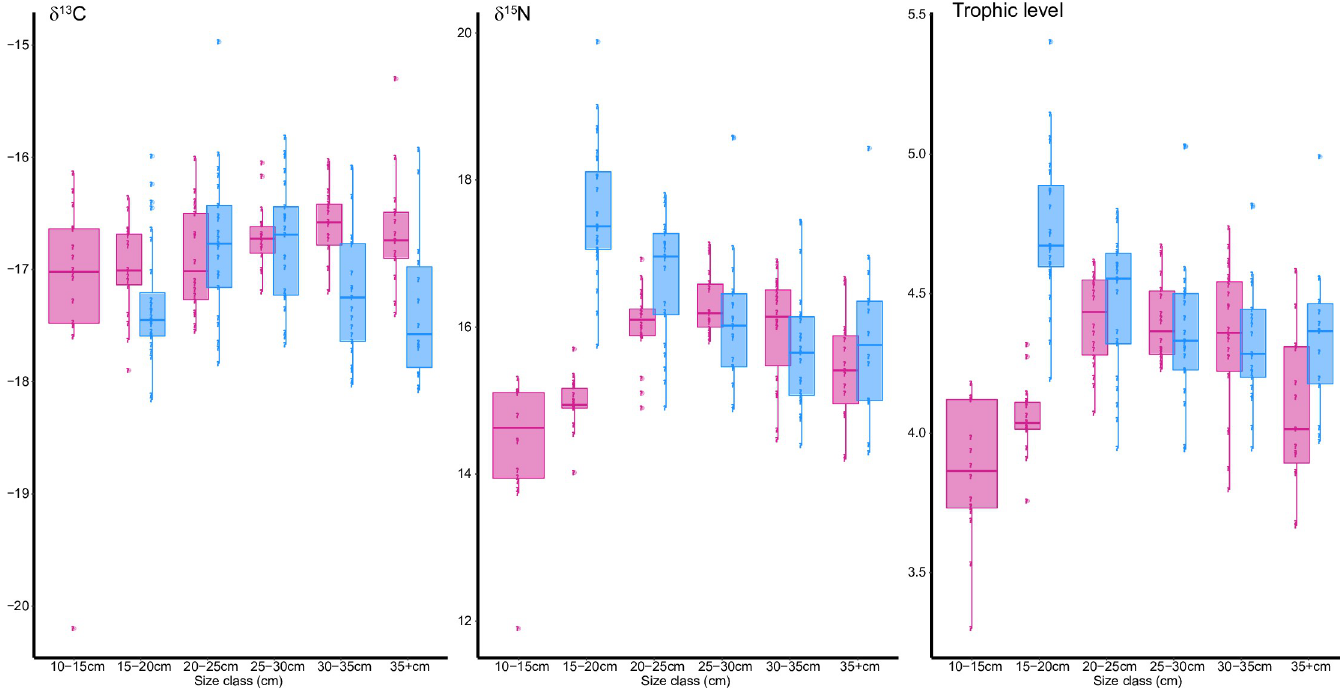
Fig 4. Relationship between δ 13 C, δ 15 N and trophic level according to size classes in autumn and winter respectively (autumn in red and winter in blue). The edges of the boxes are the first and third quartiles, the horizontal lines are median values. Outliers are calculated using 1.5 times interquartile space (distance between the first and third